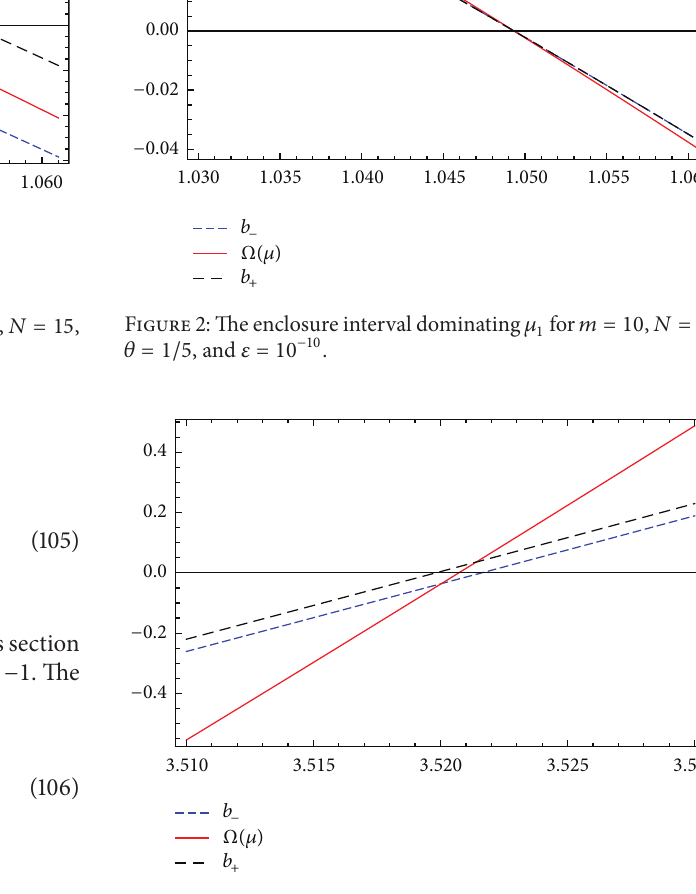
Figure 3: The enclosure interval dominating 𝜇 2 for 𝑚 = 10 , 𝑁 = 15 , 𝜃 = 1/5 , and 𝜀 = 10 −5